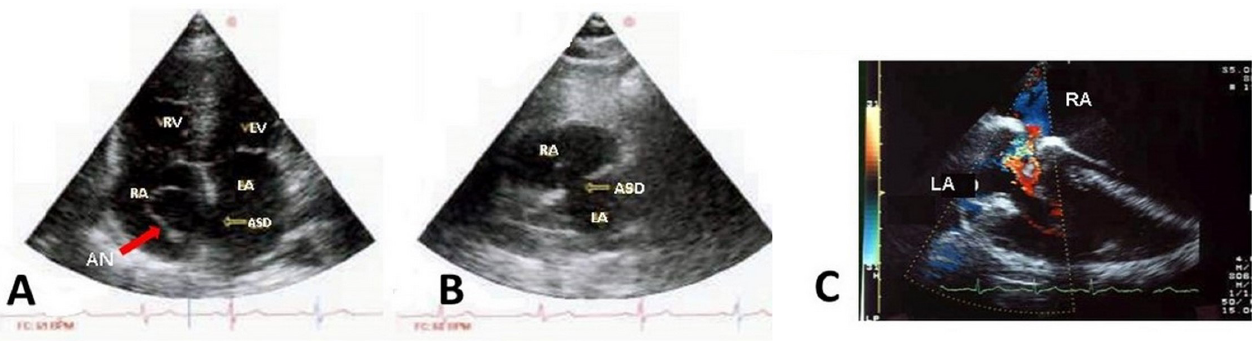
Fig. 1 - Transthoracic echocardiogram. A) The red arrow points to the atrial septal aneurysm; B) the arrow points to the atrial septal defect (ASD); and C) the echo Doppler shows the ASD flow. AN=aneurysm; LA=left atrium; LV=left ventricle; RA=right atrium; RV=right ventricle.